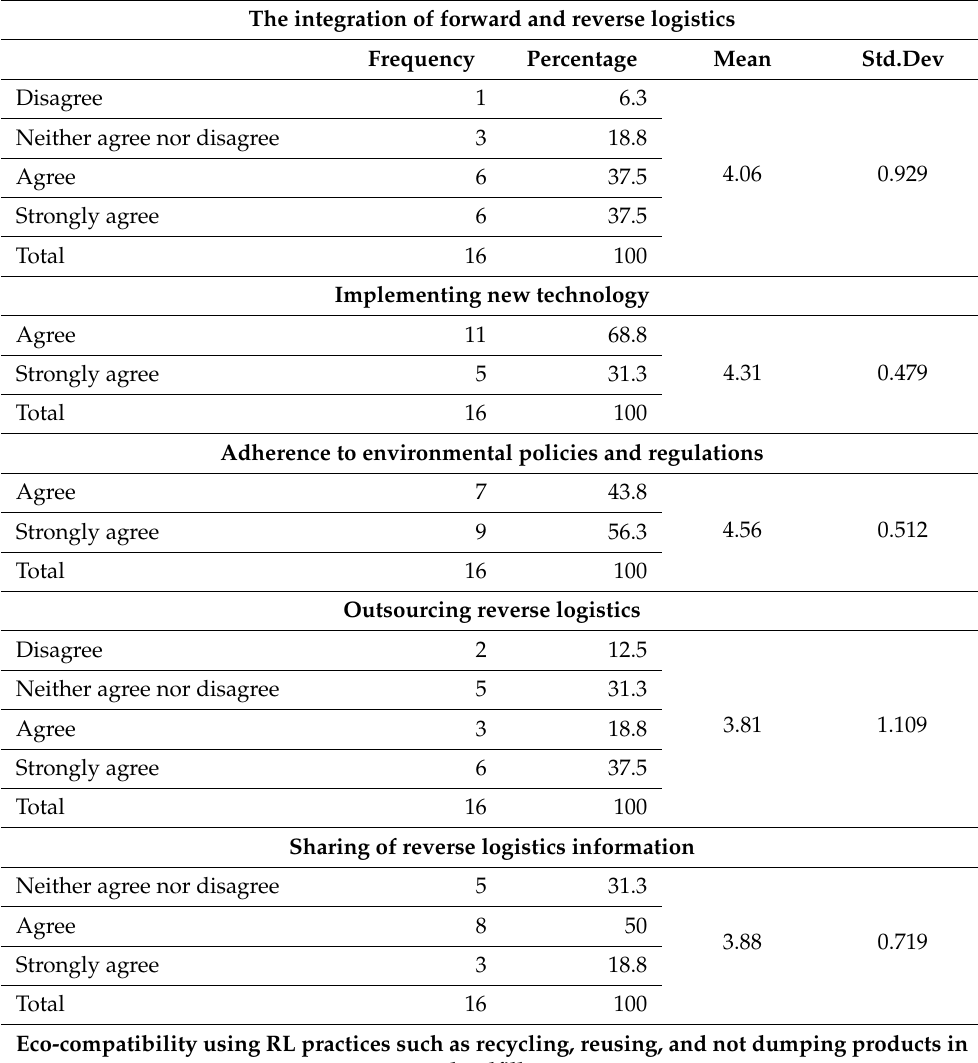
Table 5. RL strategies implemented by FMCG retailers based on